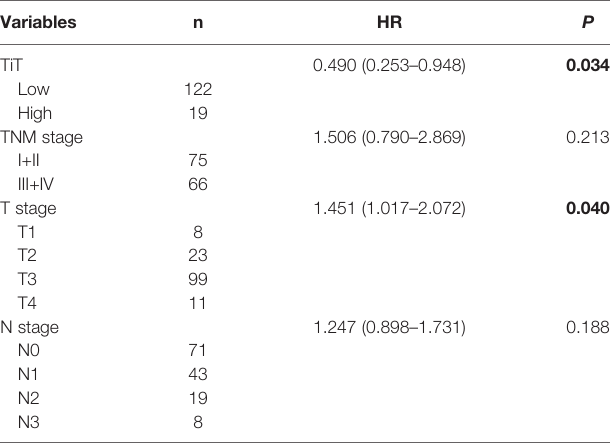
TABLE 4 | Multivariate Cox regression analysis of overall